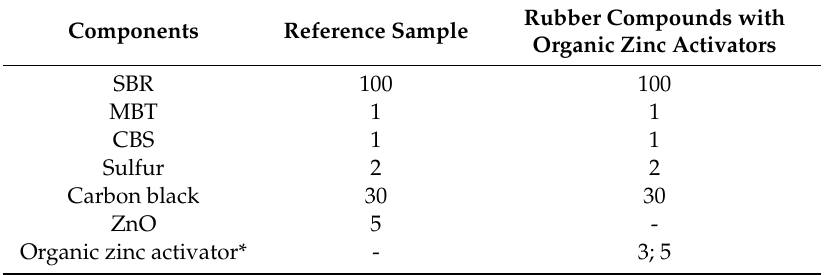
Table 1. General composition of styrene–butadiene elastomer (SBR) compounds, parts per hundred Table 1. General composition of styrene – butadiene elastomer (SBR) compounds, parts per hundred Table 1. General composition of styrene – butadiene elastomer (SBR) compounds, parts per hundred Table 1. General composition of styrene – butadiene elastomer (SBR) compounds, parts per hundred of rubber (phr) of of